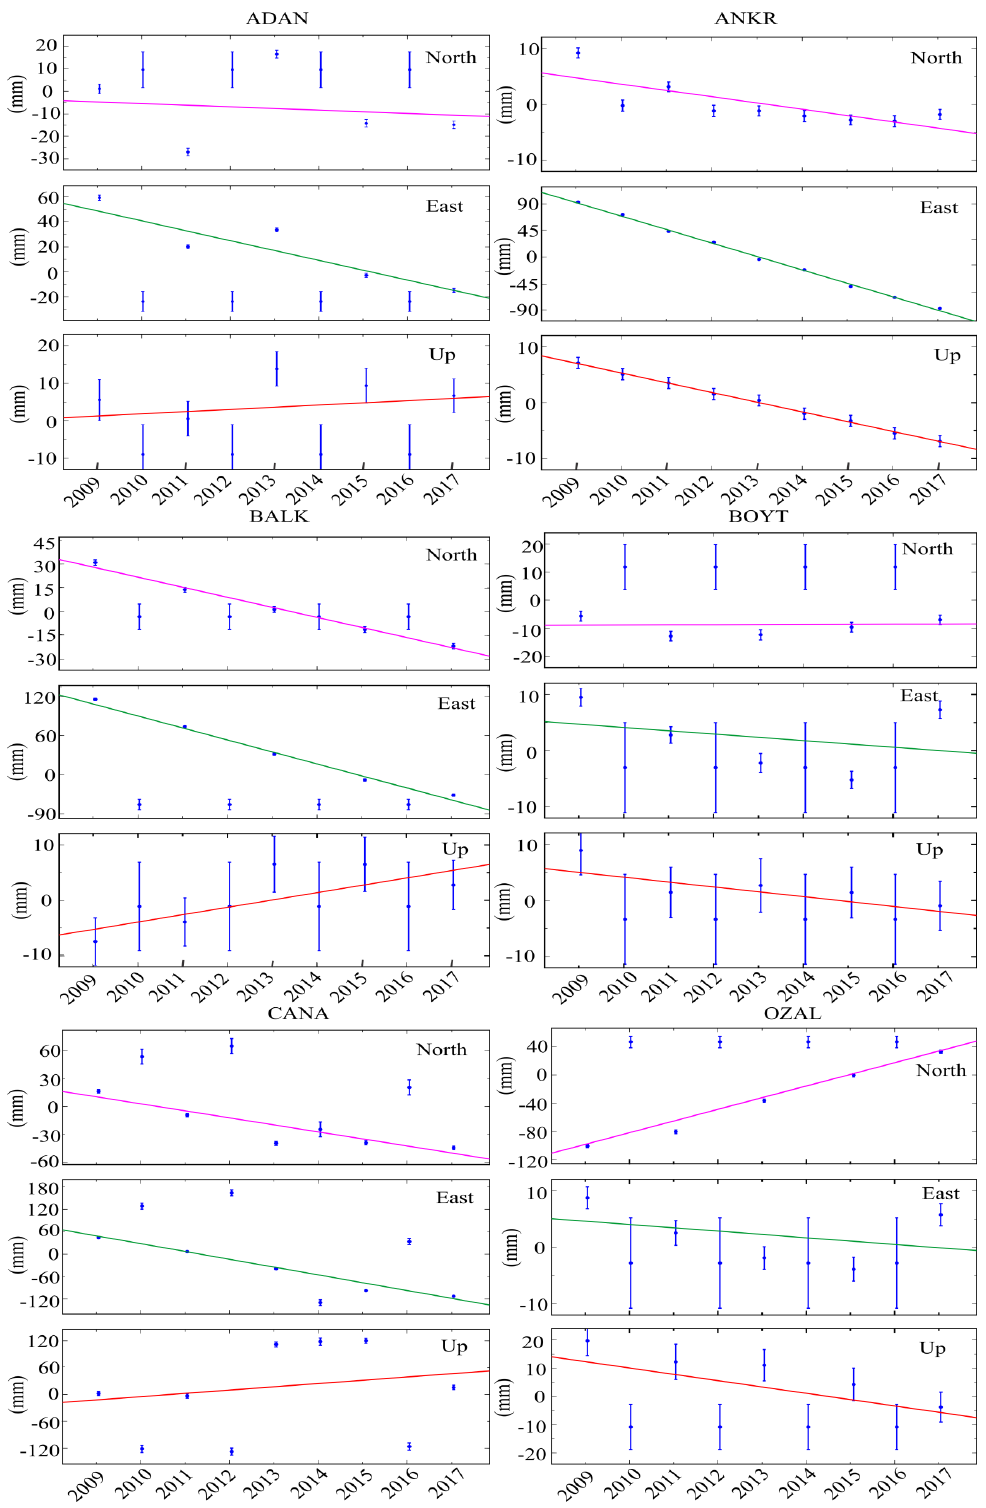
Figure 4: The changes in baseline length relative to an arbitrary zero-offset for the period 2009 to